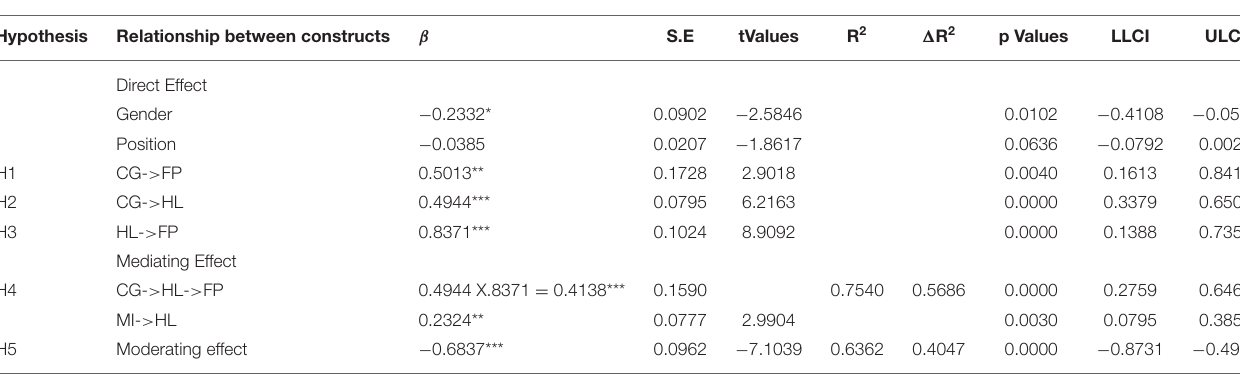
TABLE 5 | Mediation and moderation